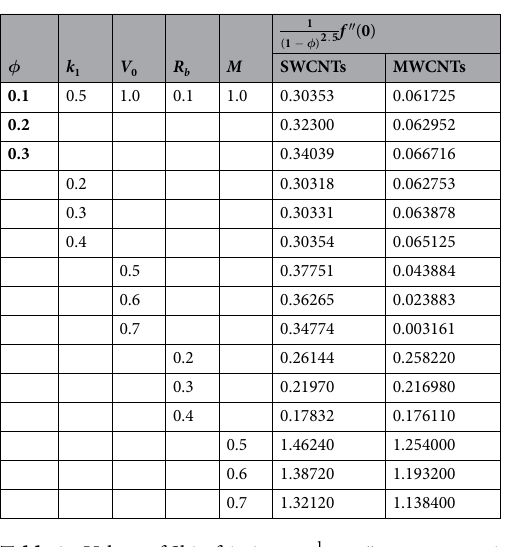
Table 3. Values of Skin friction ″ versus various estimates of different parameters. φ − and chemical reaction parameter. To see the impact of certain parameters on Motile density number, Table 6 is formed. It is witnessed that Motile density number escalates for the values of microorganism concentration difference parameter and Peclet number. Whereas it deteriorates for increasing estimates of Rayleigh number.